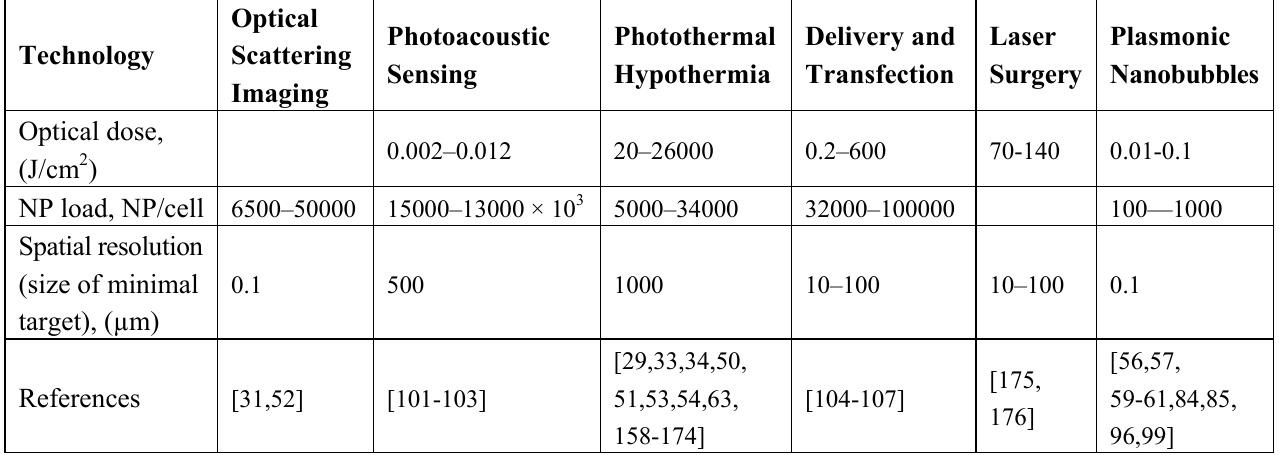
Table 6. Typical doses of optical radiation, NP loads per cell and spatial resolution/selectivity for gold NP-based